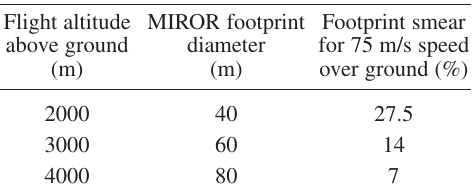
Table II. Footprint diameter and smear for various flight altitudes above ground.